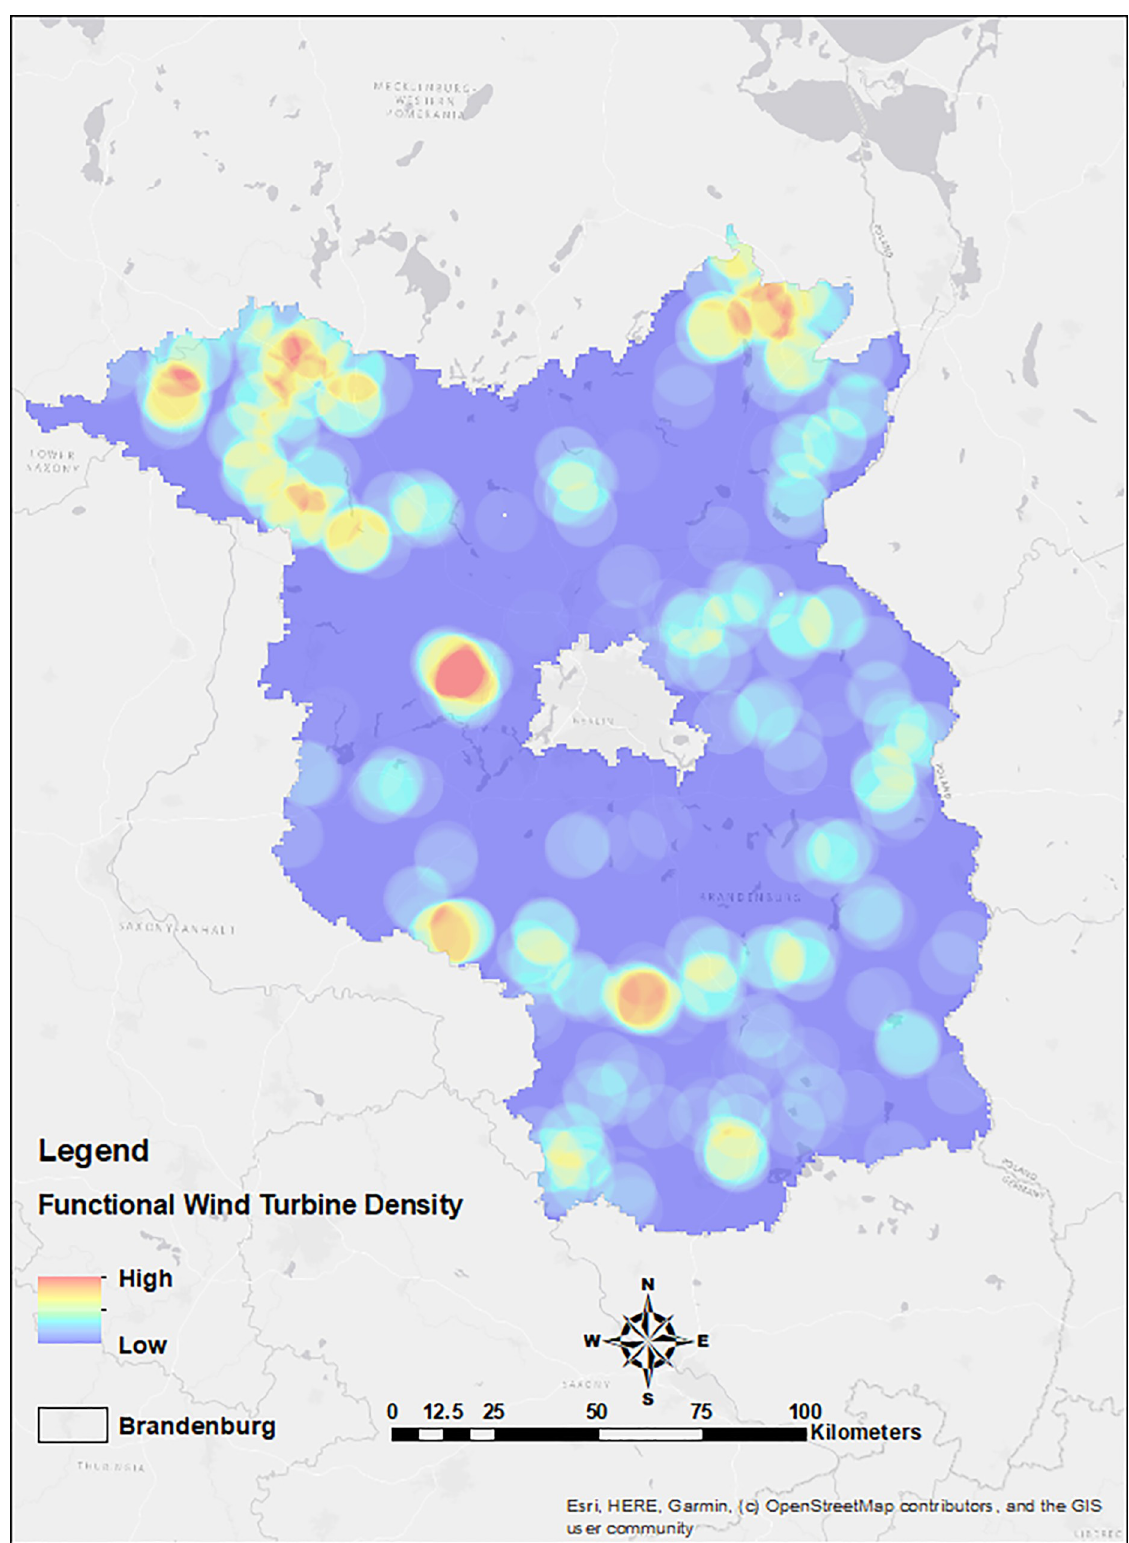
Fig 9. Functional wind turbine density in the study region of Brandenburg, Germany.